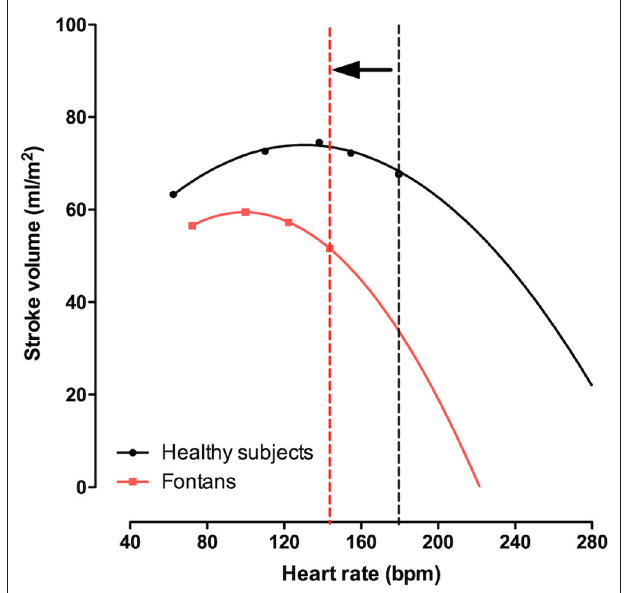
FIGURE 5 | Stroke volume index vs. heart rate during exercise. In Fontan patient heart rate and exercise capacity is limited. In a significant proportion of Fontan patients, heart rate relative to workload is preserved (or even increased). Nevertheless, heart rate reserve is still reduced, which may be a physiologic mechanism preventing a full in stroke volume (and cardiac output). This highlighted in the figure, where the infliction point (vertical dashed line) beyond which a further increase in heart rate would result in falling cardiac